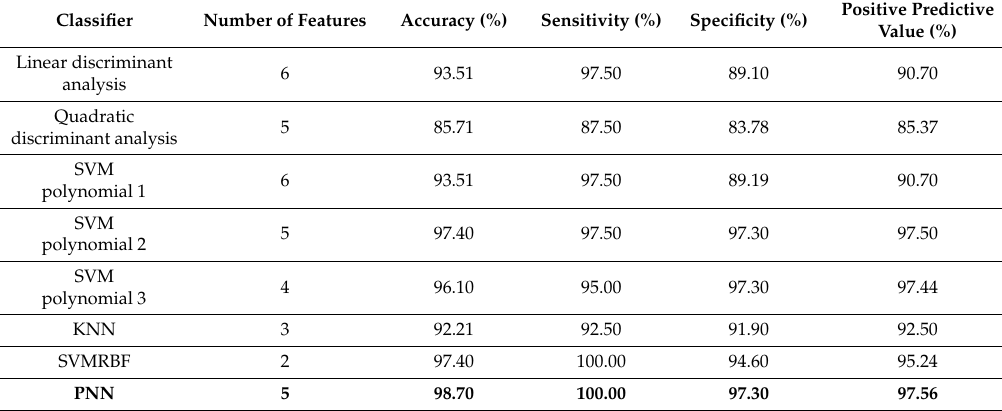
Table 1. Classification results of the various classifiers. KNN: k -nearest neighbor; SVMRBF: support vector machine with radial basis function; PNN: probabilistic neural network.